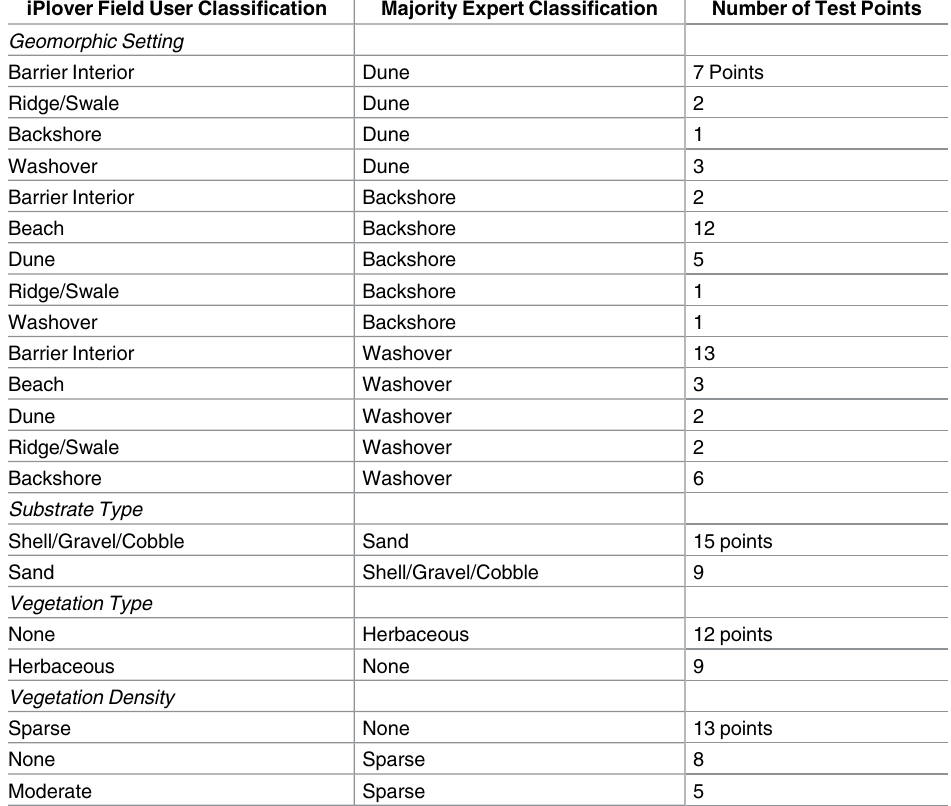
Moderate Sparse 5 a The most common differences between the majority expert classification and the iPlover field user dataset. Differences shown here account for 90%, 86%, 81%, and 74% of the differences for Geomorphic Setting, Substrate Type, Vegetation Type, and Vegetation Density, respectively, between the majority expert classification and the iPlover field user